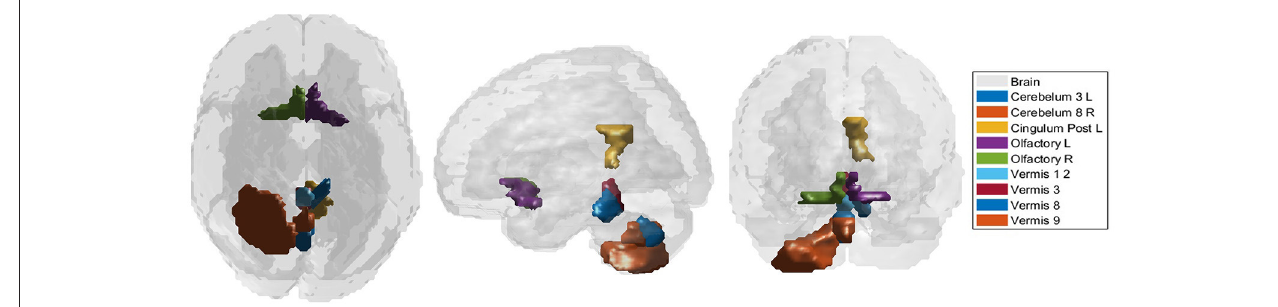
FIGURE 3 | The significant regions as obtained through the two sample t -test.